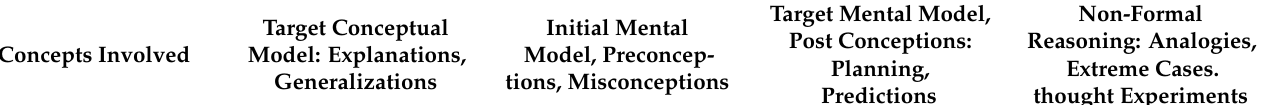
Table 4. Nonformal reasoning for creative mindset in the short Bebras task (elaborated by the